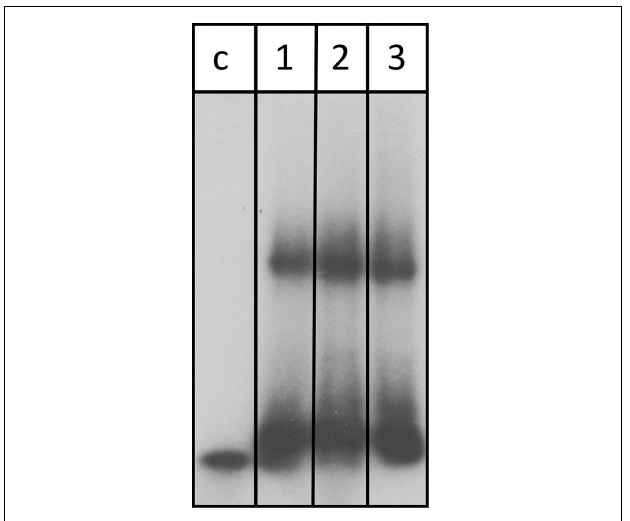
FIGURE 10 | s479 binds to the znu C1 mRNA in vitro . Labeled s479 was incubated with increasing concentrations of a znu C1 mRNA fragment, containing the predicted interaction site 2 ( Figure 7D ). Reactions were loaded onto a nondenaturing polyacrylamide gel. Lane c: control reaction without the addition of znu C1, lane 1: addition of 50 pmol znu C1, lane 2: addition of 100 pmol znu C1, lane 3: addition of 200 pmol znu